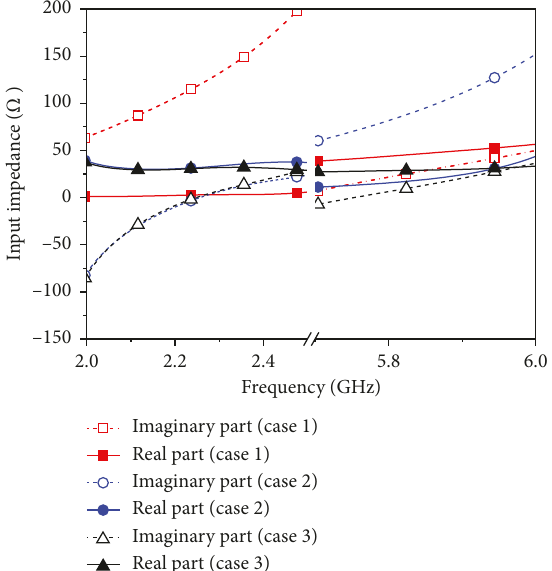
Figure 4: Simulated input impedances (real and imaginary parts) of different cases (case1: without longer strips; case 2: without shorter strips; and case 3: proposed antenna).